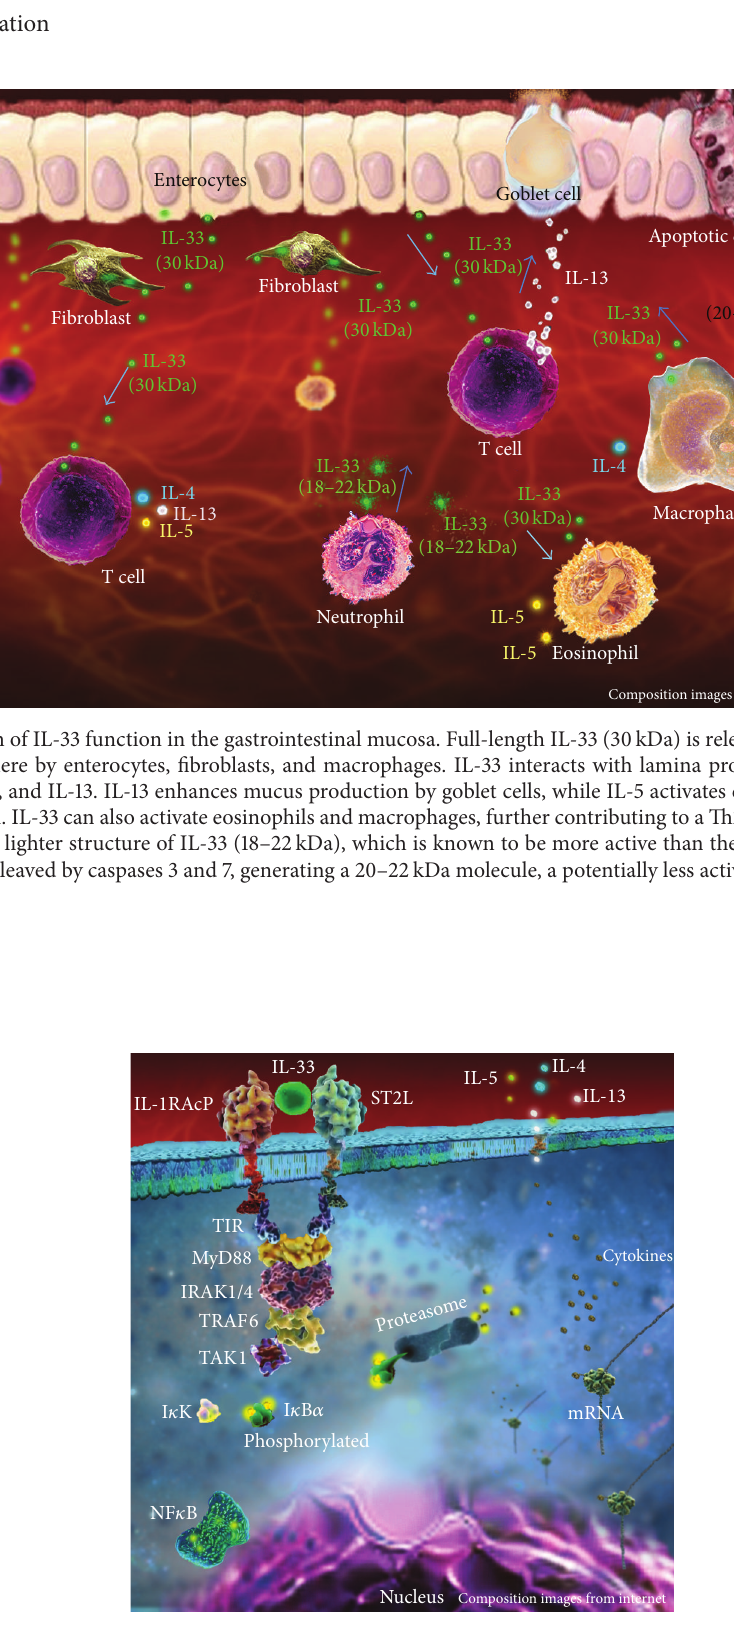
Figure 2: Representation of IL-33 pathway in T-helper cells. IL-33 interacts with ST2L and the receptor accessory protein IL-RAcP in the membrane. Both possess a domain TIR that allows interacting with MyD88, IRAK1/4, TRAF6, and TAK1 in the cytosol. These intracellular signaling molecules determine I 𝜅 K inactivation by phosphorylation and degradation in proteasome complex. The consequent NF 𝜅 B activation results in the production of Th2